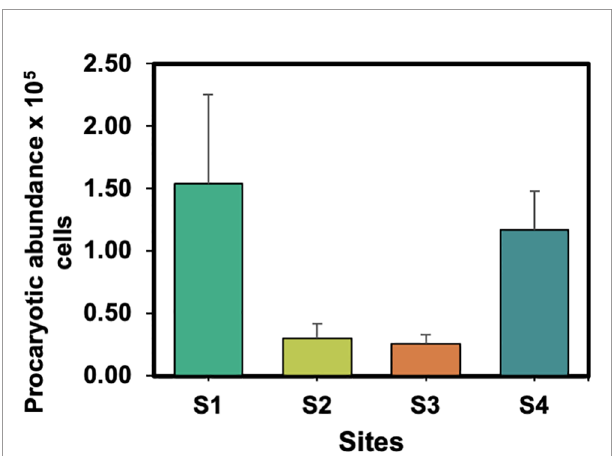
FIGURE 3 | Prokaryotic abundance on plastics sampled from aquaculture areas (mean ±